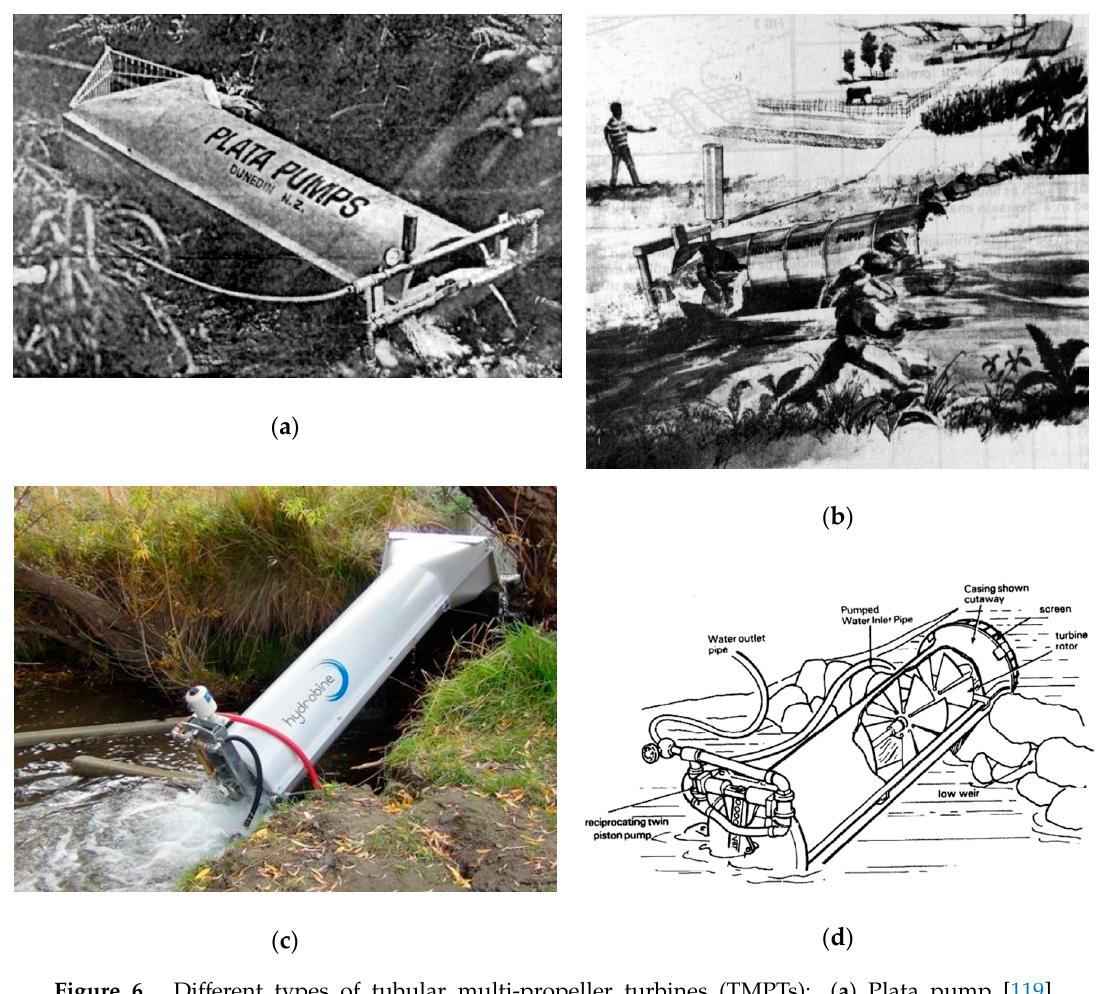
Figure 6. Di ff erent types of tubular multi-propeller turbines (TMPTs): ( a ) Plata pump [119]. Reproduced with permission from Alternative Technology Association Inc. © The Alternative Technology Association (https: // www.jstor.org / stable / softtechaltetech.13.18); ( b ) Illustration of a Turbopump in operation [122]. © S.C. White (http: // www.wossac.com / search / wossac_detail.cfm? ID = 2076); ( c ) Hydrobine in operation [123]. Reproduced with permission from Wayne Perkins. © EB Engineering Solutions (https: // www.facebook.com / Hydrobine / photos / pcb.789312184518066 / 789311851184766 / ?type = 3&theater). Cropped from the original; ( d ) Schematic view of a TMPT [14]. Reproduced with permission from Food and Agriculture Organization of the United Nations © FAO (http: // www.fao.org / 3 / ah810e /